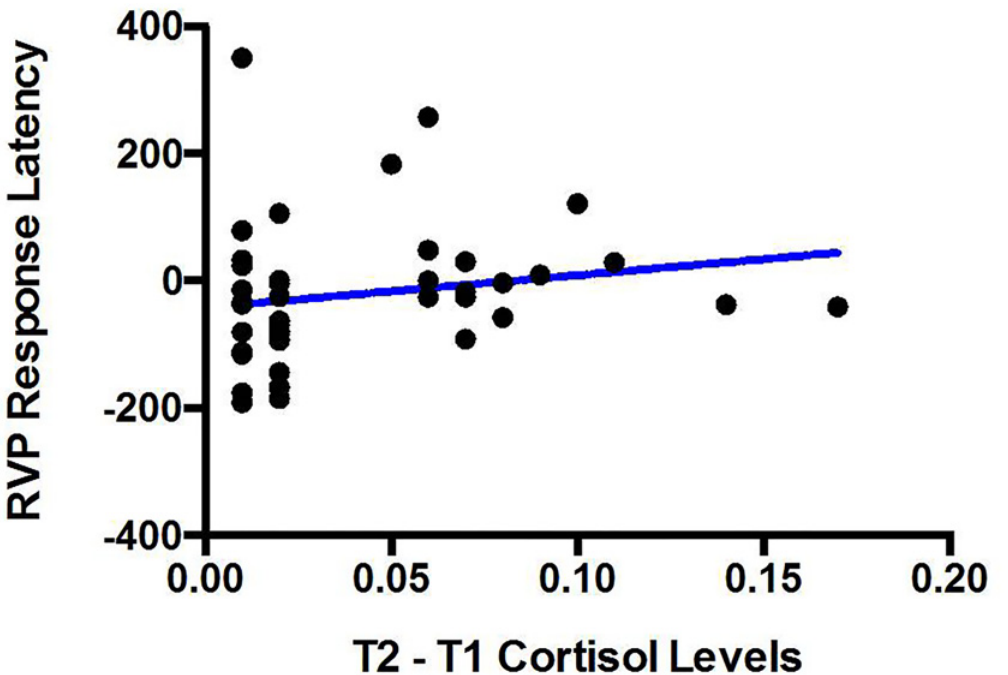
Fig 4. Correlation between between T2 — T1 cortisol levels (X Axis) and T2 — T1 RVP Response Latency (Y Axis) within the subsample of participants showing TSST-induced increases in cortisol